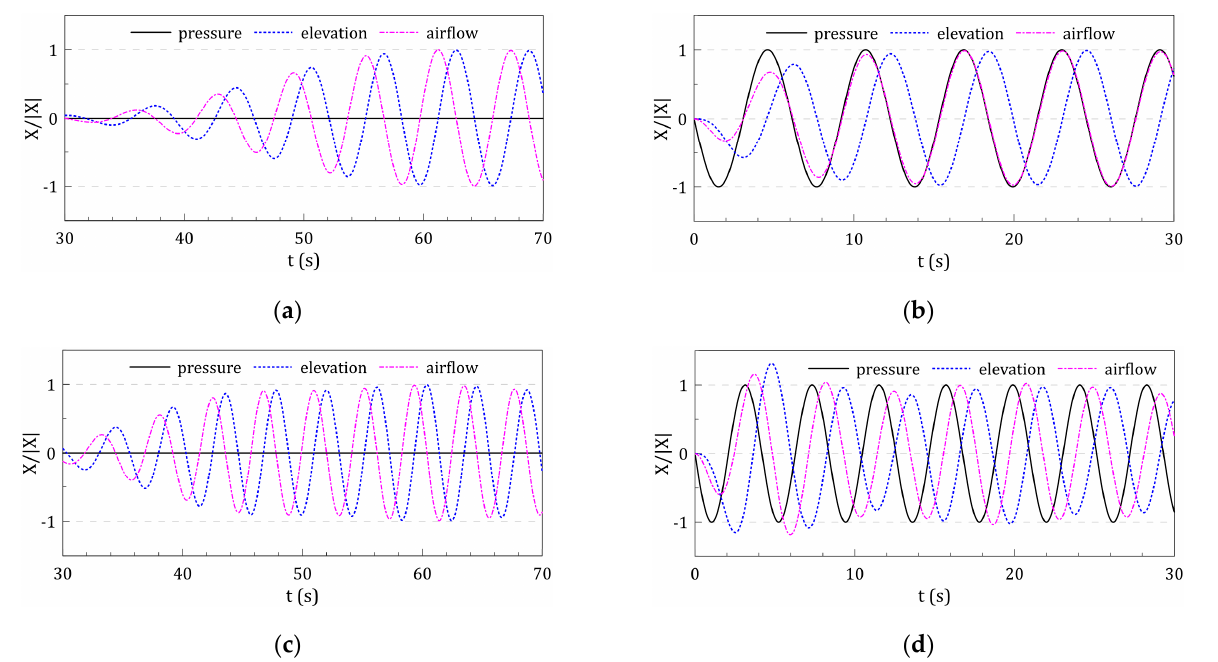
Figure 7. Time-series data of free-surface elevation inside the chamber, airflow, and pressure drop in the OWC chamber: ( a ) wave excitation simulation, ω = 1.0 rad/s; ( b ) forced radiation simulation, ω = 1.0 rad/s; ( c ) wave excitation simulation, ω = 1.5 rad/s; ( d ) forced radiation simulation, ω = 1.5 rad/s.